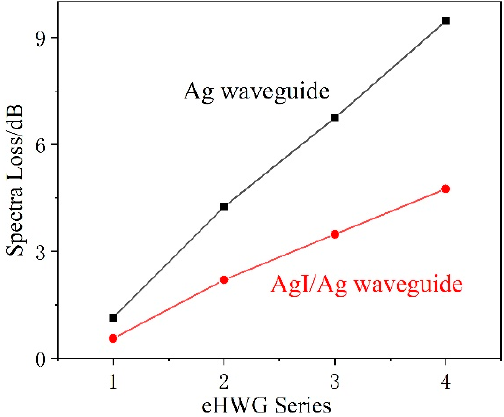
Figure 4. Loss spectra of the eHWGs with ( a ) an Ag waveguide or ( b ) an AgI/Ag waveguide.